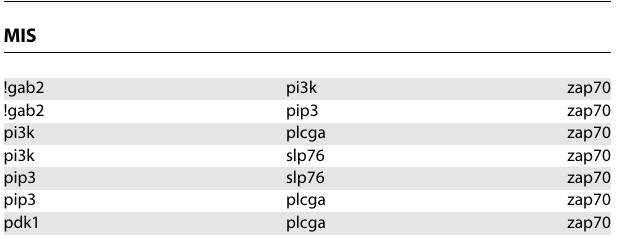
Table 3. Minimal Intervention Sets To Produce the Full Activation Pattern in T